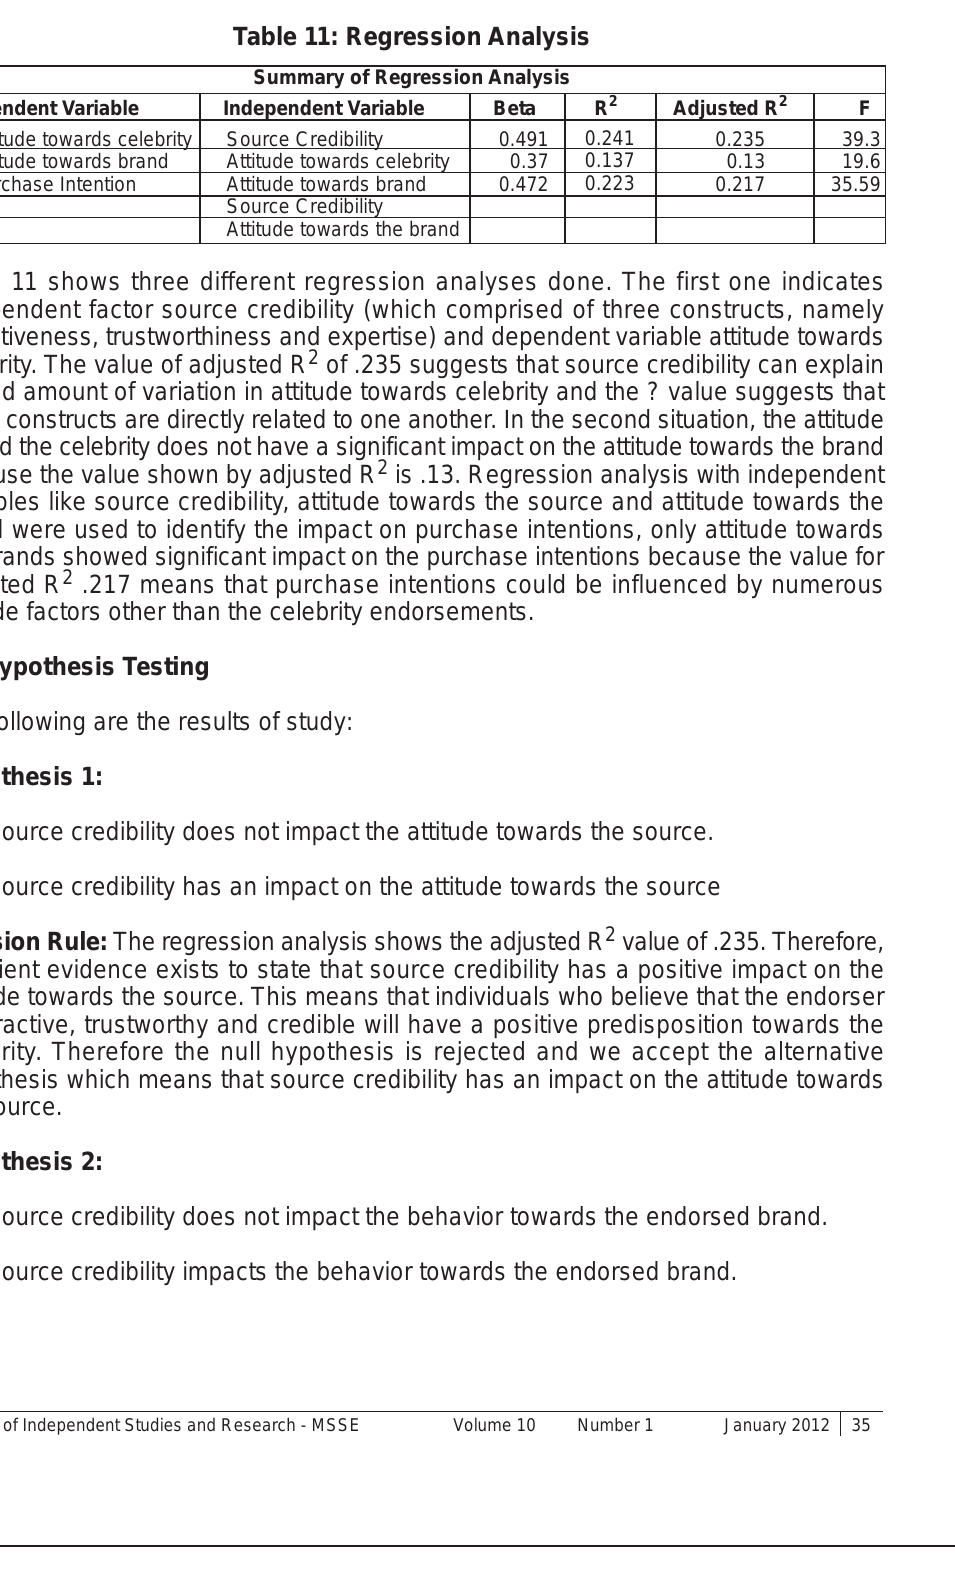
Table 11: Regression